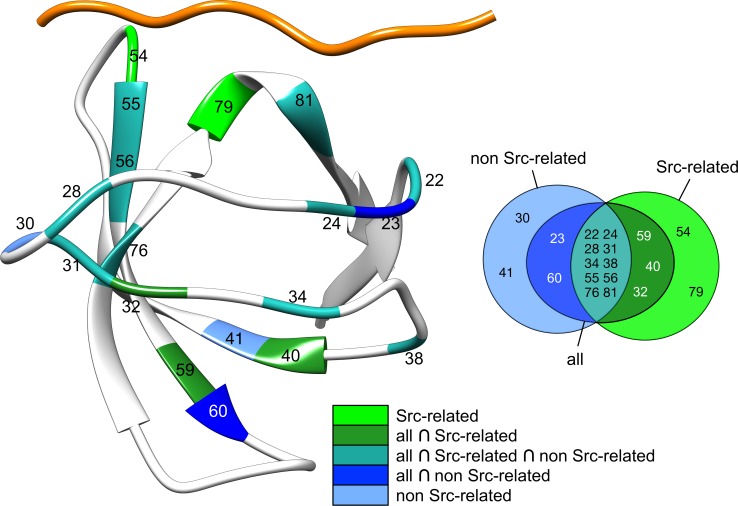
Overlap in consensus rankings.The consensus rankings for the top fifteen residues are mapped on the structure of Src SH3 (same structure used in Fig 1A) with different colors (see legend), e.g. in light cyan are highlighted the residue positions that are consistently ranked in the first 15 positions in all the three consensus rankings, while in light green are highlighted those appearing in the top 15 positions only in the consensus of the SH3 domains from the Src kinases family.